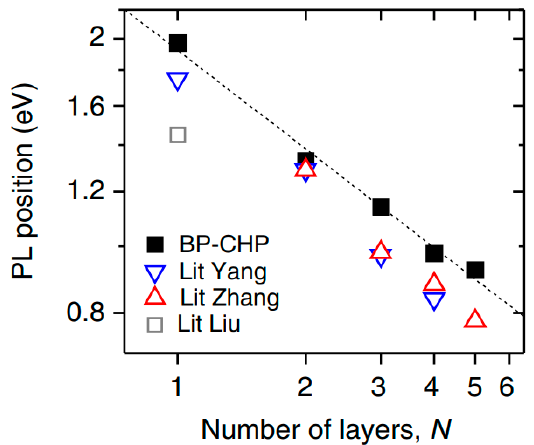
Figure 3. Photoluminescence of black phosphorous nanosheets. Position of PL lines plotted versus layer number: ■ —BP nanosheets were exfoliated by sonication in solvent of N-cyclohexyl-2-pyrrolidone (CHP); ∆ , ▼ , □ —data for mechanically cleaved BP nanosheets taken from Refs. [54,57,58]. Reproduced from Ref. [59]. Published by Macmillan Publishers Limited as open access, 2015.